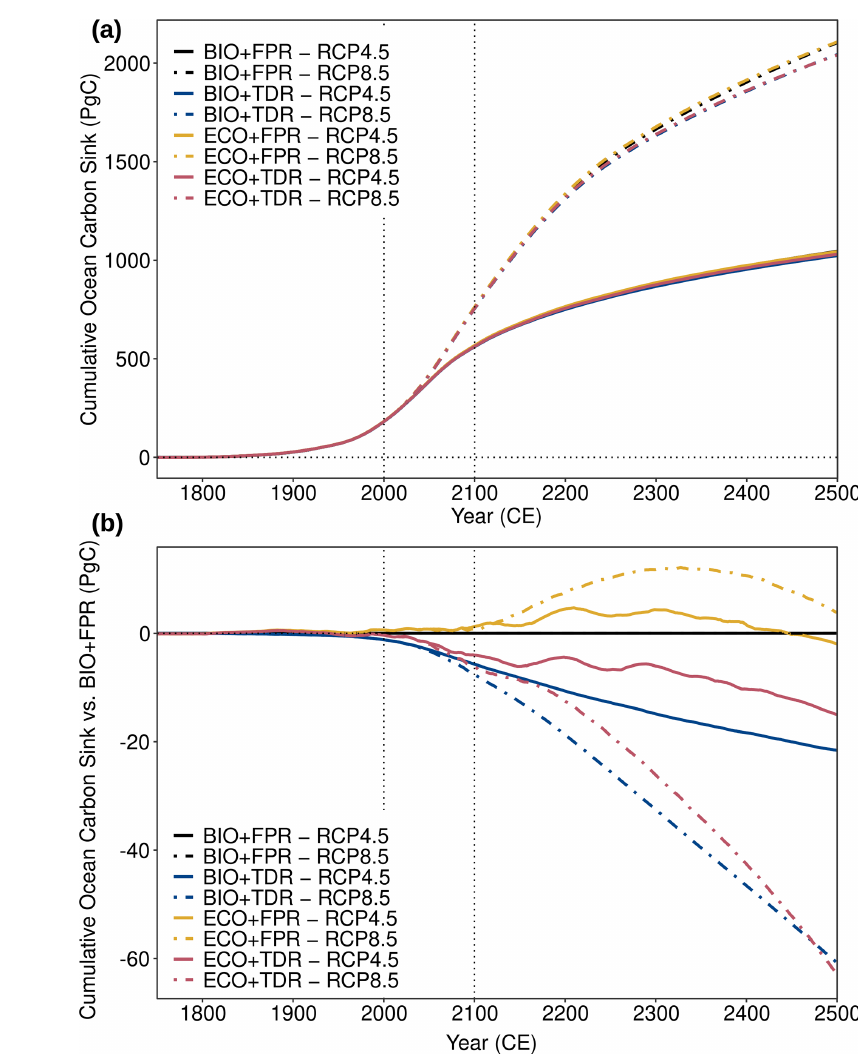
Figure 5. cGEnIE and ecoGEnIE simulation results for (a) the absolute cumulative ocean carbon sink and (b) the cumulative ocean carbon sink relative to BIO+FPR under different configurations and forcing scenarios. Results for RCP4.5 (solid lines) and RCP8.5 (dot-dashed lines) are shown for each of the default calibration configurations (BIO+FPR – black; BIO+TDR – blue; ECO+FPR – yellow; ECO+TDR – red), and the 21st century is marked by the vertical dotted